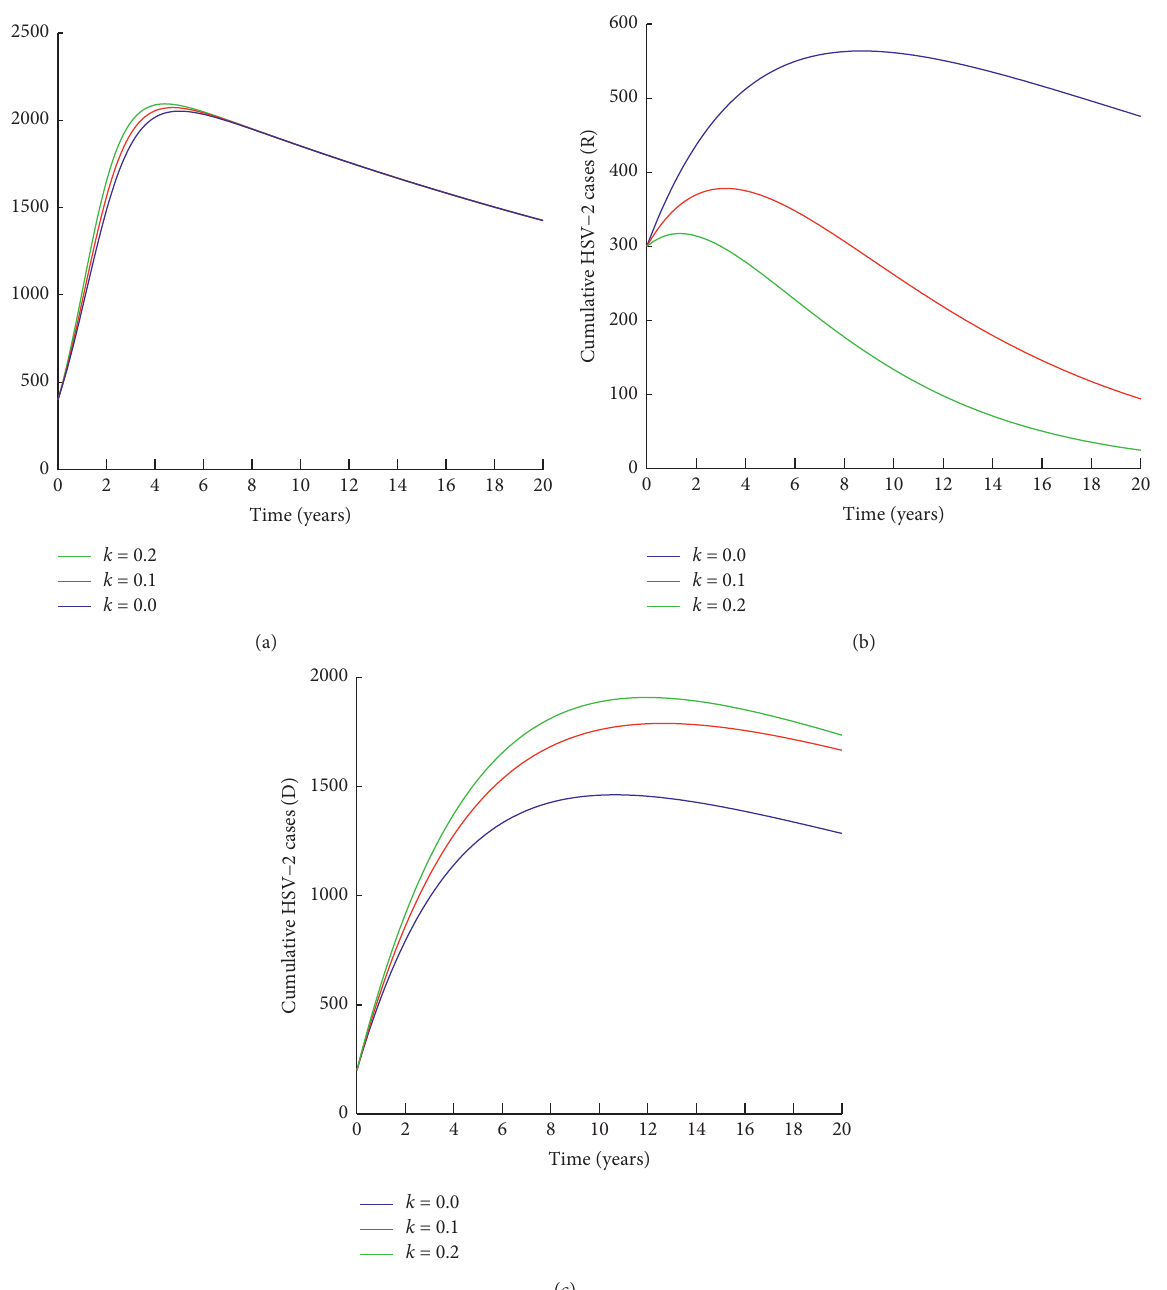
Figure 2: Time series plots showing the effect of increasing relapse rate k on (a) infectious population who are not on treatment I , (b) infectious on treatment but still having sex with other men, and (c) infectious on treatment and no longer having sex with other men, over a period of 20 years. The rest of the parameters are as presented in Table 1, and the following assumed initial conditions were used: S � 2000 ,I � 400 ,R � 300 , D �